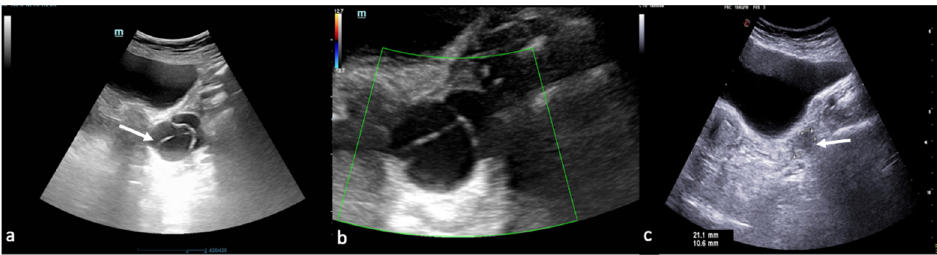
Figure 4. Haemorrhagic left ovarian cyst. Axial US image ( a ) shows a hemorrhagic cyst (( a ) arrow) with reticular structure. On colour-Doppler imaging ( b ) there is no blood flow of the reticular structure. At follow-up ( c ) a complete resorption of the cyst is observed (( c ) arrow). In addition, unlike a true septum, they do not extend from one wall of the cyst to the other. The lack of flow detected by the colour Doppler imaging is an important feature,